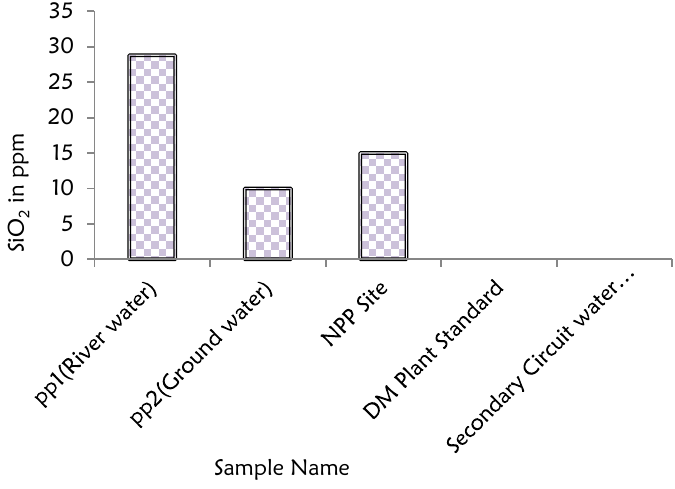
Figure 6: Analysis of the quality of SiO 2 between raw water and DM water with